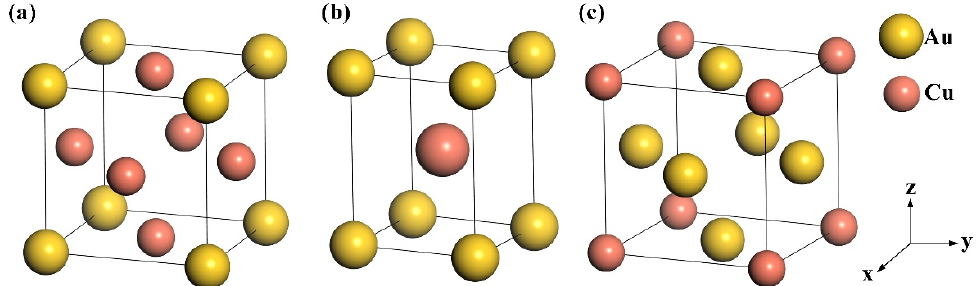
Figure 1. Crystal structures of gold–copper (Au–Cu) intermetallic compounds (IMCs): ( a ) AuCu 3 , ( b ) AuCu, and ( c ) Au 3 Cu.